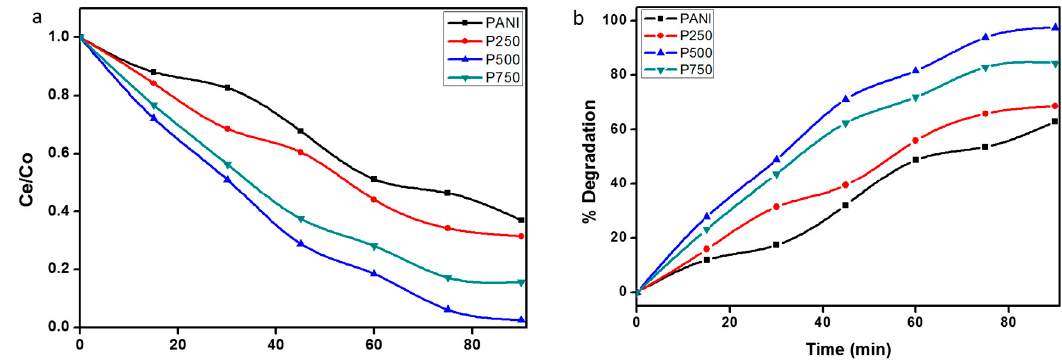
Figure 10. ( a ) Photodegradation rate of MB at different time intervals in the presence of various photocatalysts; ( b ) Percentage degradation of MB in the presence of various photocatalysts.